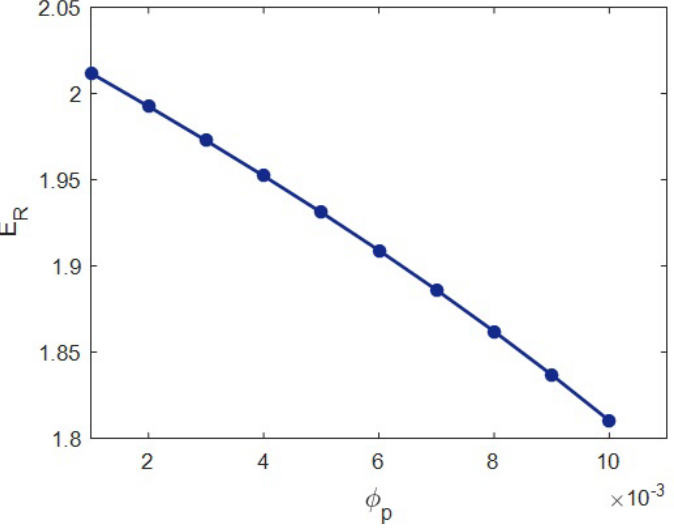
Figure 8. The calculations of formulated model at several series of percolation onset.